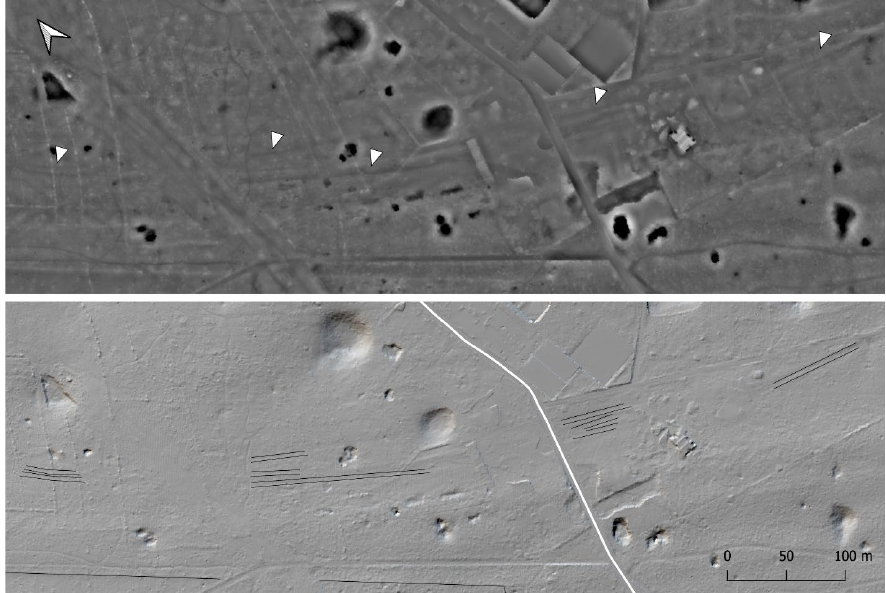
Figure 9. Zoomed view of area D of Figure 2 with the position of road tracks indicated by white arrows in the upper picture (local relief model of an ALS-derived DTM) and by black lines in the lower one (hill-shaded image of an ALS-derived DTM). Modern roads are indicated by white lines. In area E, a caliga hobnail of type A has been found along the road (Figure 5, n. 10).